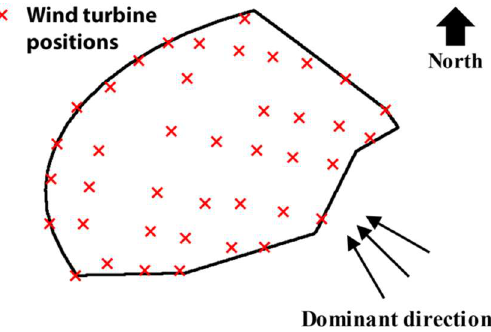
Figure 10. Results of wind farm layout optimization with different number of wind turbines under variable wind speeds and variable wind directions: ( a ) wind farm power production and ( b ) wind farm power losses. Appl. Sci. 2018 , 8 , x FOR PEER REVIEW 11 of 15